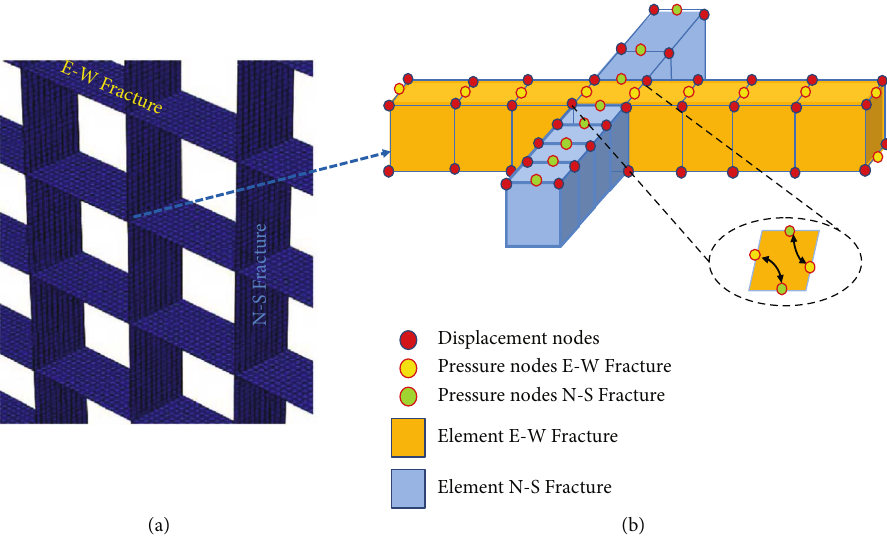
Figure 7: (a) Schematic diagrams of intersections of three-dimensional cohesive elements; and (b) presents the shared pressure nodes to guarantee the continuity of pore pressure at the point of intersection